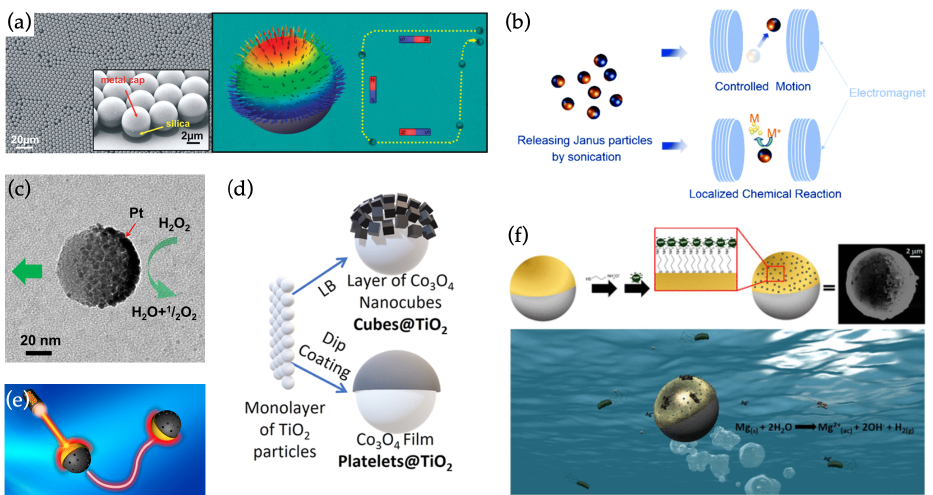
Figure 3. Non-hybrid swimmers made from Janus spheres. ( a ) Left: a metal cap on silica beads induces a magnetic response. Right: magnetic moments in the metal cap at remanence after magnetic saturation. ( b ) Partially coating a particle with magnetostrictive and piezoelectric layers enables dual functions in controlled motion and localized chemical reactions. ( c ) A platinum cap on mesoporous silica enables catalysis-based fuel-free propulsion of a drug-loaded particle. ( d ) Morphological differences in coating affect the swimming behavior of particles. ( e ) Photothermally driven Au-capped silica spheres respond at near-infrared light wavelengths close to the surface plasmon resonance of the coating. ( f ) Mg nanospheres half-coated with a Fe/Au bilayer and topped with bactericidal Ag nanoparticles form multifunctional swimmers for water remediation. ( a ) reproduced from Ref.